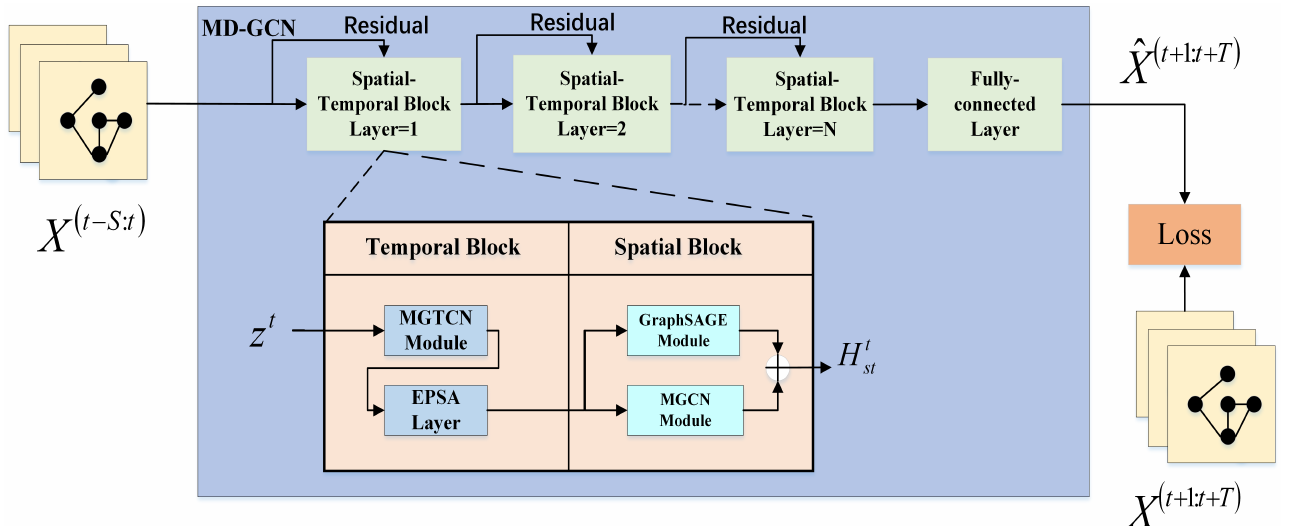
Figure 2. The model structure of